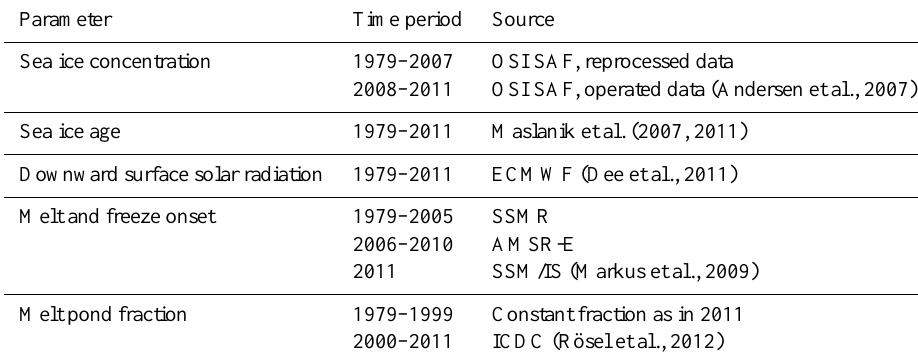
Table 2. Data sources of the different parameters used in this study.